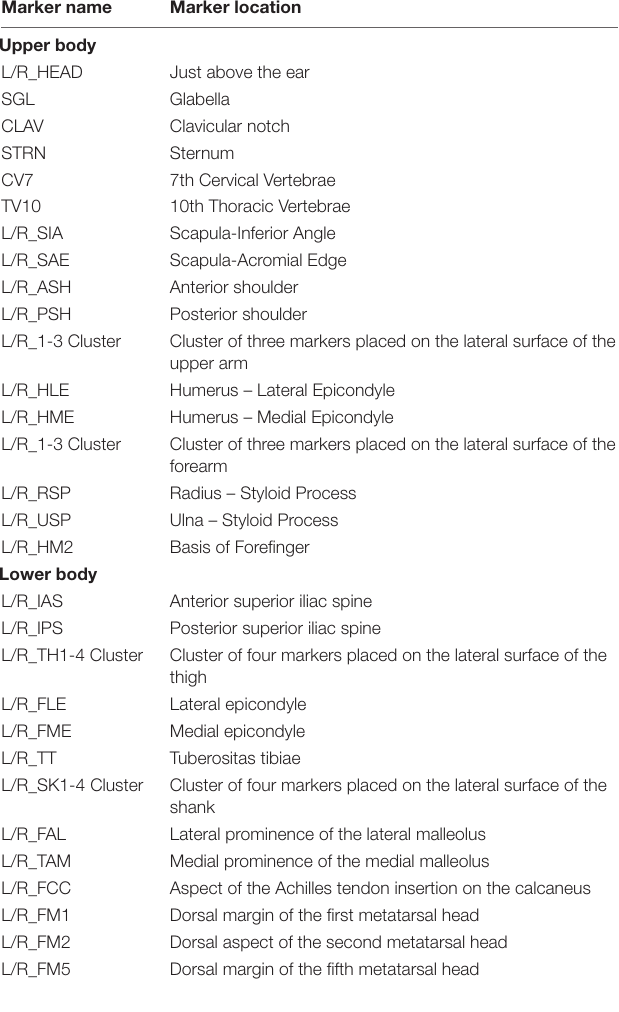
TABLE 1 | Seventy-five retroreflective markers